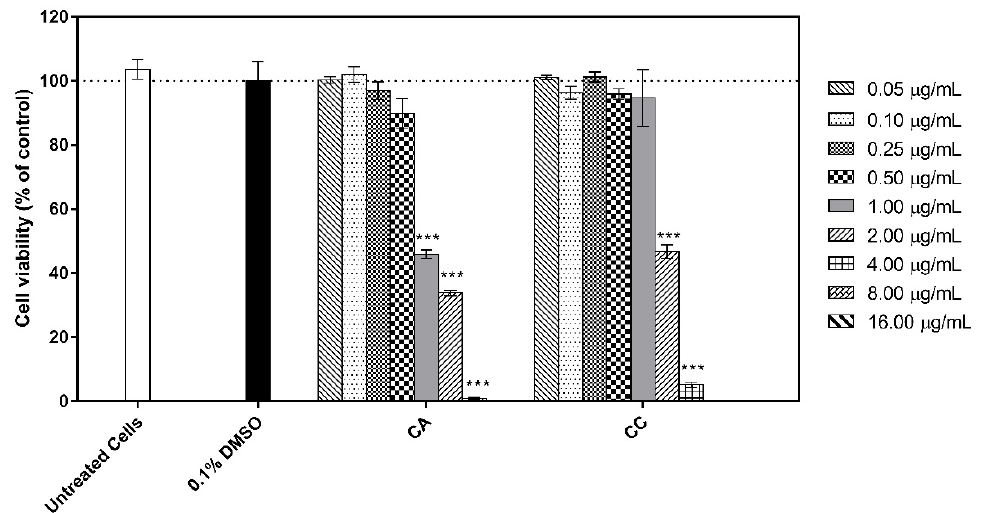
Figure 6. Cytotoxicity of CA and CC extracts against human HaCaT keratinocytes. Data are presented as the means ± SD. *** p < 0.05 compared to the control (0.1% DMSO).